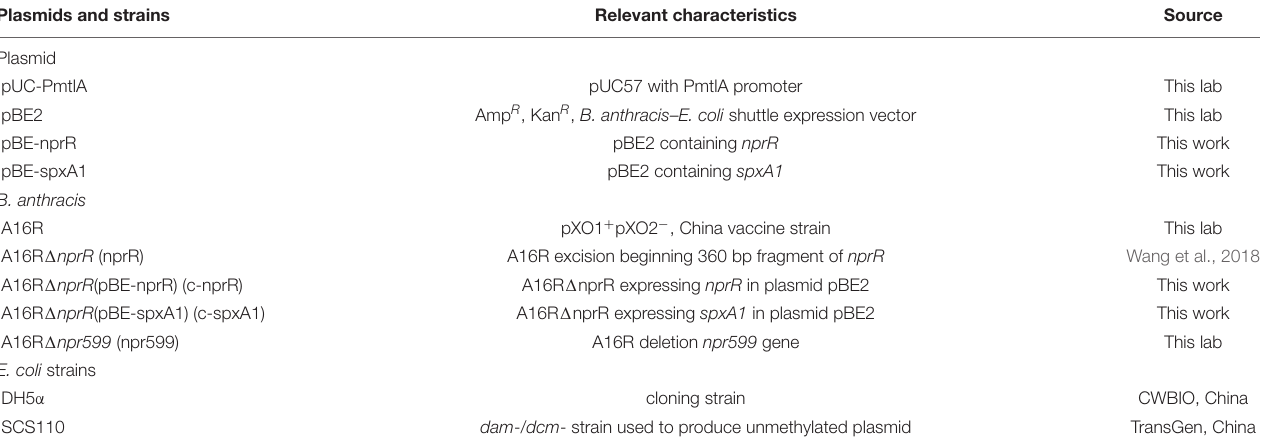
TABLE 1 | Plasmids and strains used in this